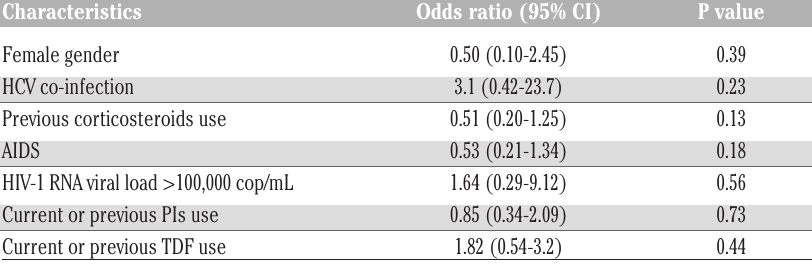
Table 1. Characteristics associated with an increased risk of fractures among patients in our